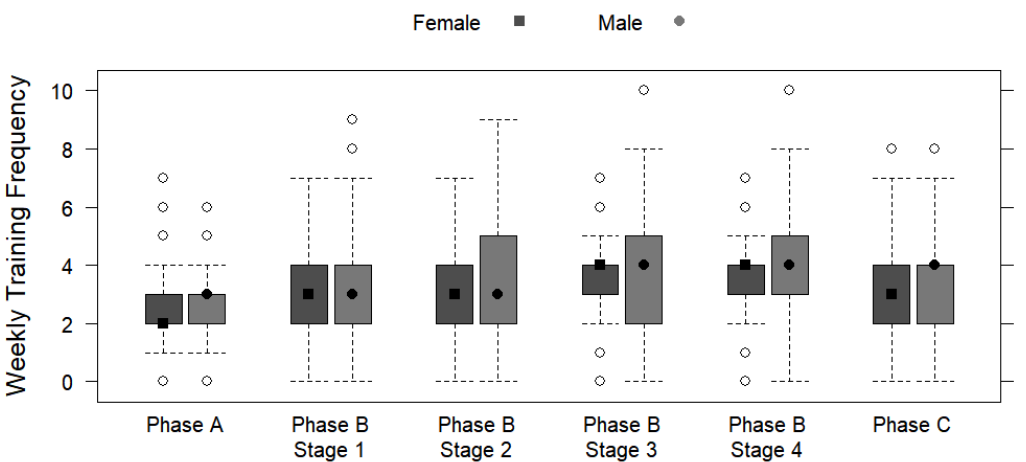
Figure 3. Box plots displaying sex differences in weekly training frequencies in different training periodization phases and stages.